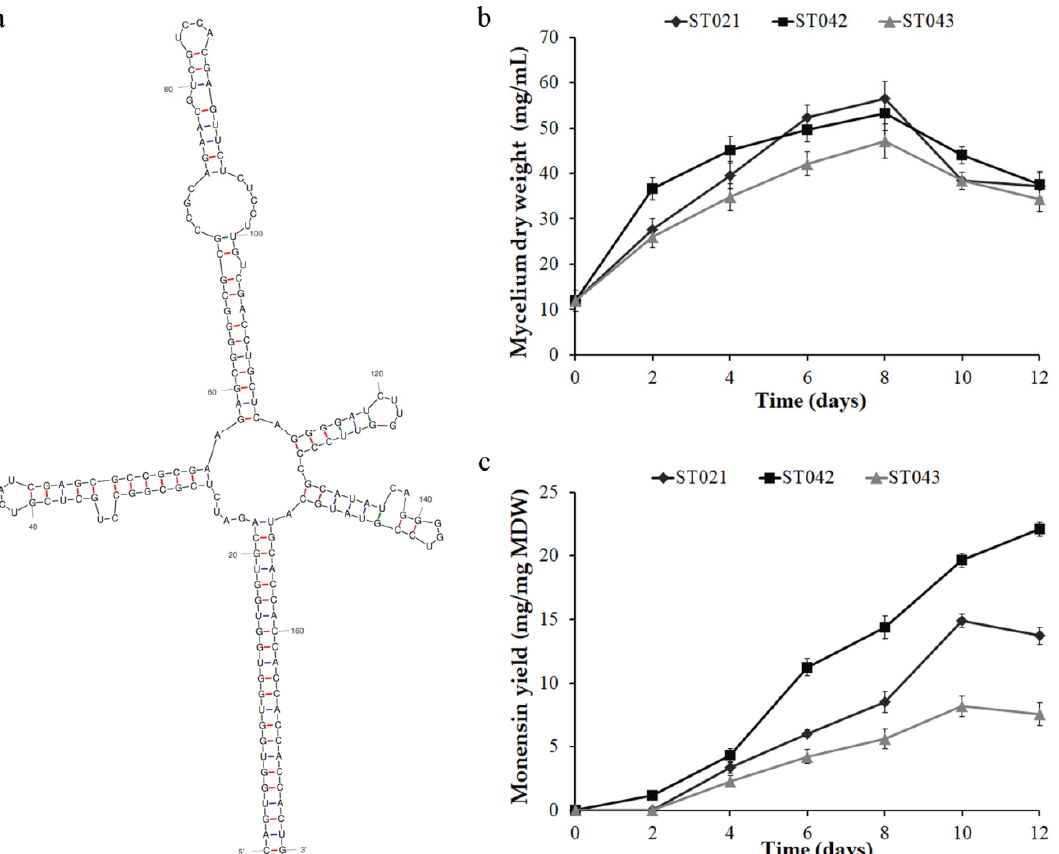
Figure 1 . The overexpression and antisense RNA silencing of the crp gene. ( a ) The predicted secondary structure of anti- crp sequences on pLCY010-csRNA vector. Mycelium dry weight (MDW) ( b ) and monensin yield ( c ) of the original strain ST021, the crp overexpression strain ST042 and the anti- crp strain ST043 of S. cinnamonensis . Error bars indicate standard deviations from three independent experiments.